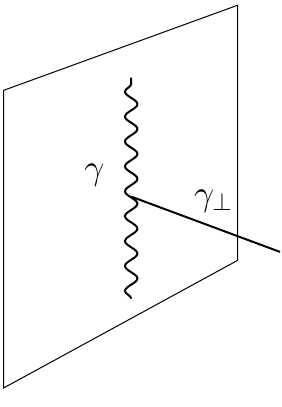
Figure 3: If a boundary line W ( γ ) is at the fixed point of the identification using a = a K , it can form a junction by emanating a bulk line exp ( iK (cid:98)